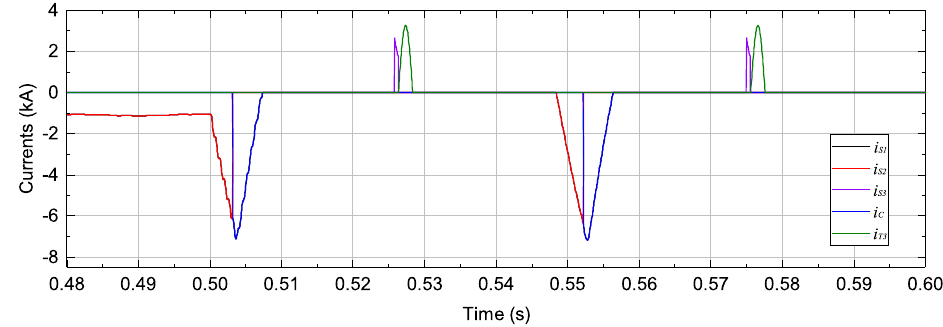
Figure 16. Overall currents on the switches of HCB 4.